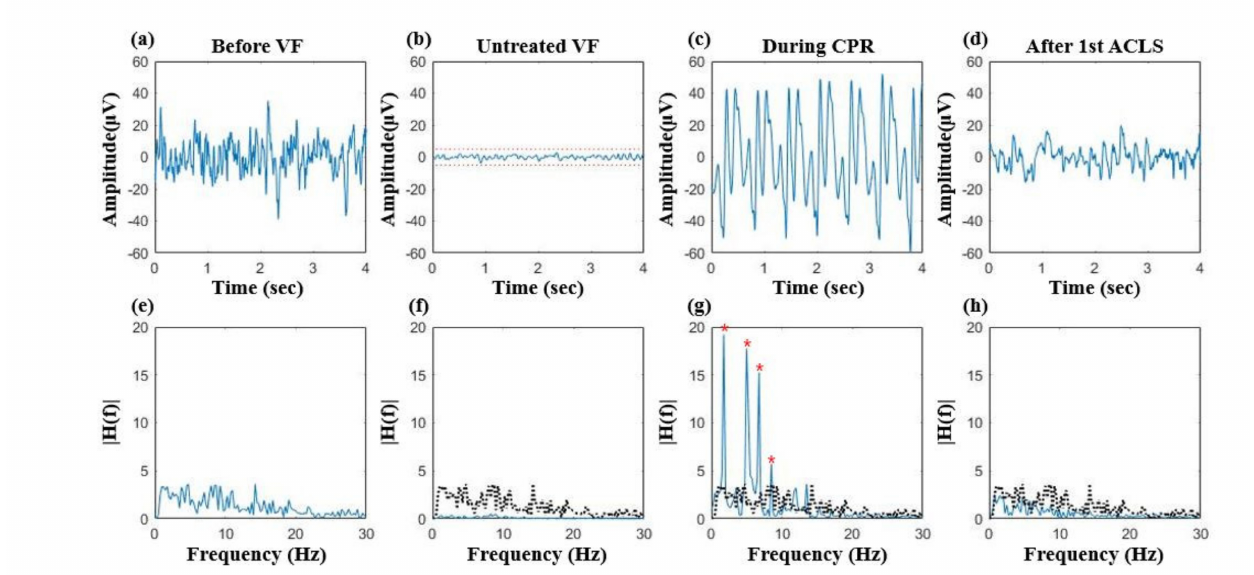
Figure 3. EEG changes in animal 1: ( a ) irregular baseline EEG activity before VF, ( b ) isoelectric EEG pattern during untreated VF, red dotted lines denote the limits of the isoelectric state ( ± 5 µ V), ( c ) severely contaminated signal during CPR, ( d ) recovered EEG activity after the 1st ACLS, ( e ) frequency response of the baseline EEG before VF, ( f ) frequency response of the isoelectric EEG during untreated VF, ( g ) frequency response of CPR artifacts, red marks denote the frequency components of CPR artifacts, ( h ) frequency response of the EEG after the 1st ACLS, a black dotted line in ( f − h ) is the frequency responses of the baseline EEG ( e ).